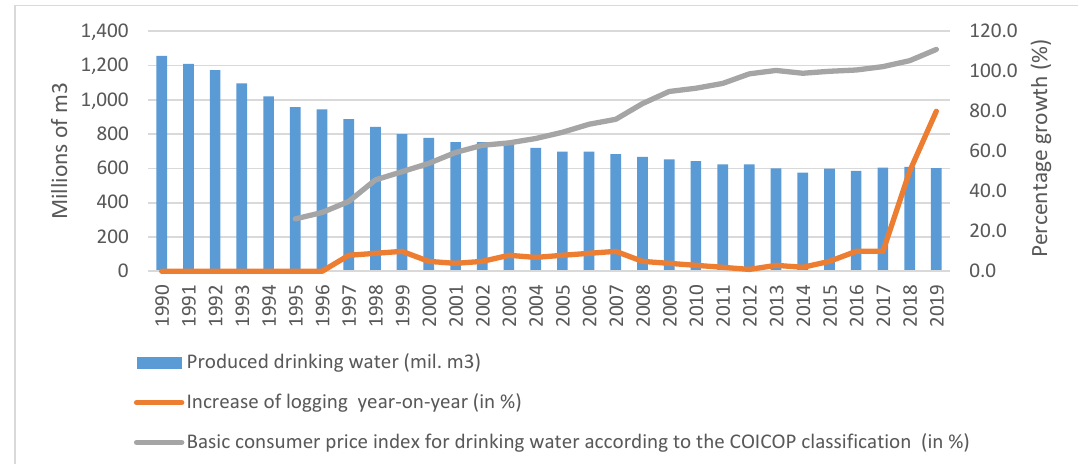
Fig 1. Proportion of drinking water production, prices index and logging